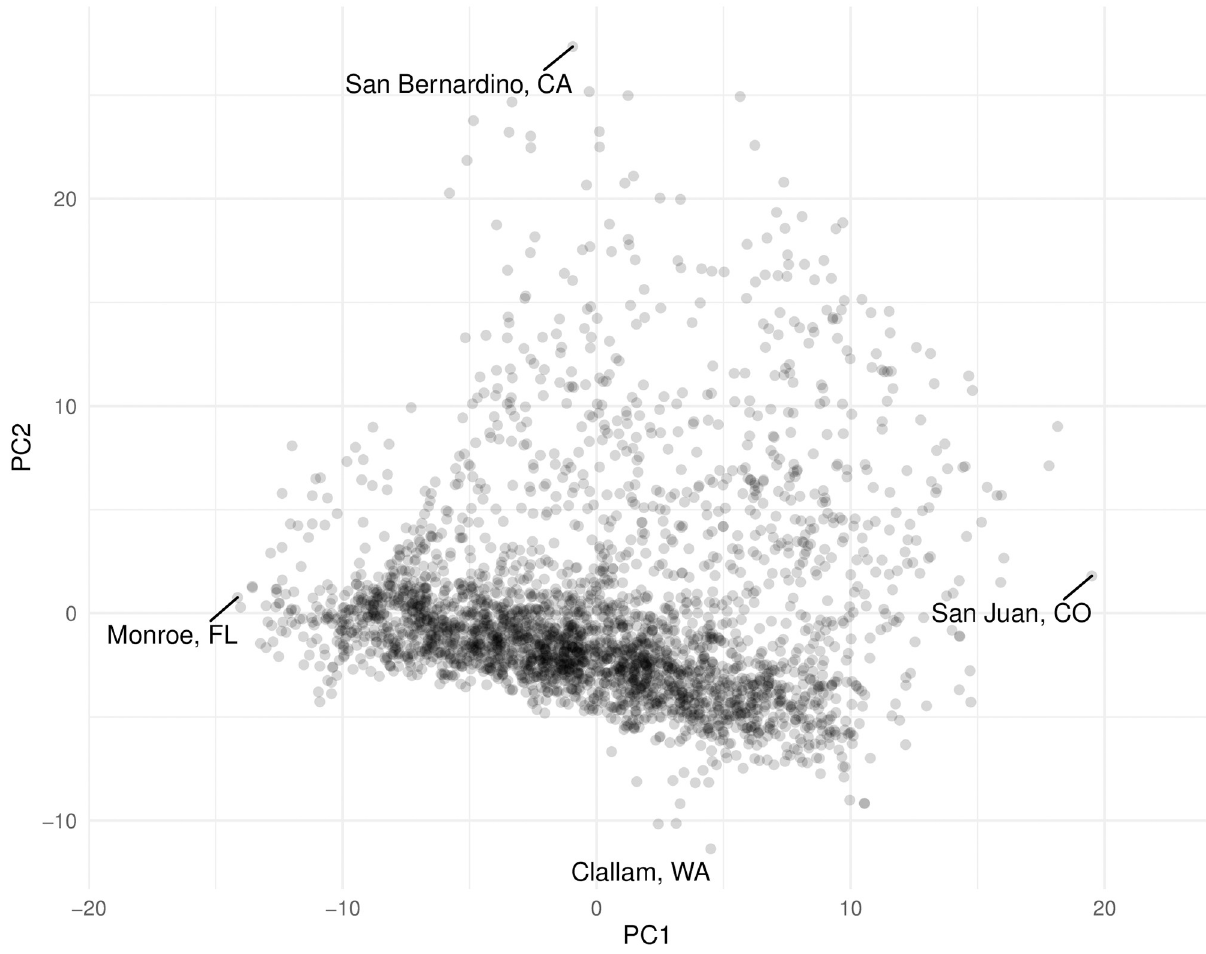
Fig 2. County-level weather data projected to 2 dimensions with